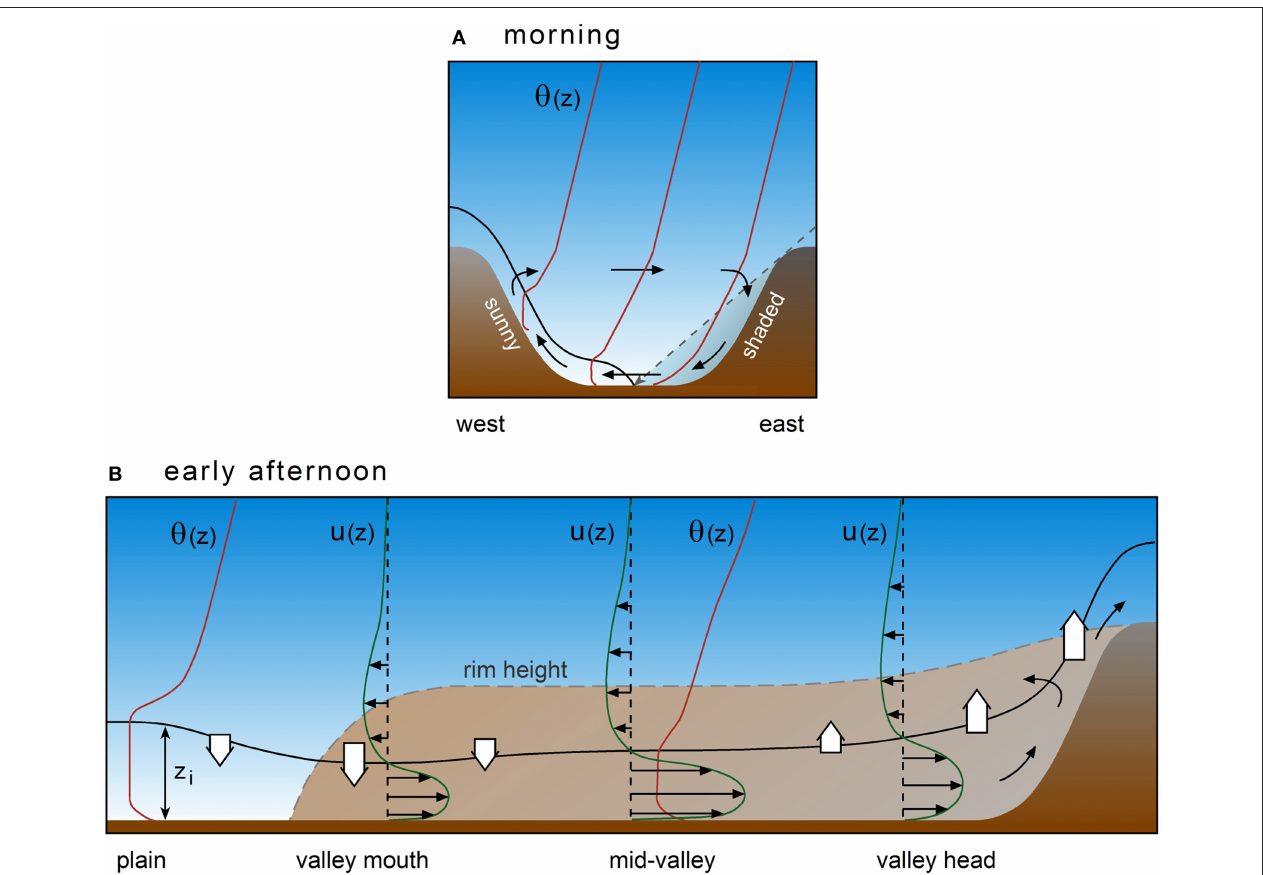
FIGURE 6 | Vertical cross sections of thermal wind circulation and CBL structure in a valley for (A) a cross valley section during the morning transition and (B) an along valley section around noon or mid-afternoon. The solid black line indicates CBL depth z i . Thin solid vectors indicate airflow components in the cross section direction. Red solid lines indicate vertical profiles of potential temperature θ (z). The dashed line in (A) indicates a sun ray which separates the sunny and shaded parts of the valley. Green lines in (B) indicate vertical profiles of the horizontal along-valley wind component with the horizontal black vectors depicting the direction of the flow. Curved black vectors and vertically pointing white arrows indicate subsidence or lifting at the CBL top caused by horizontal divergence or convergence of the along-valley airflow.